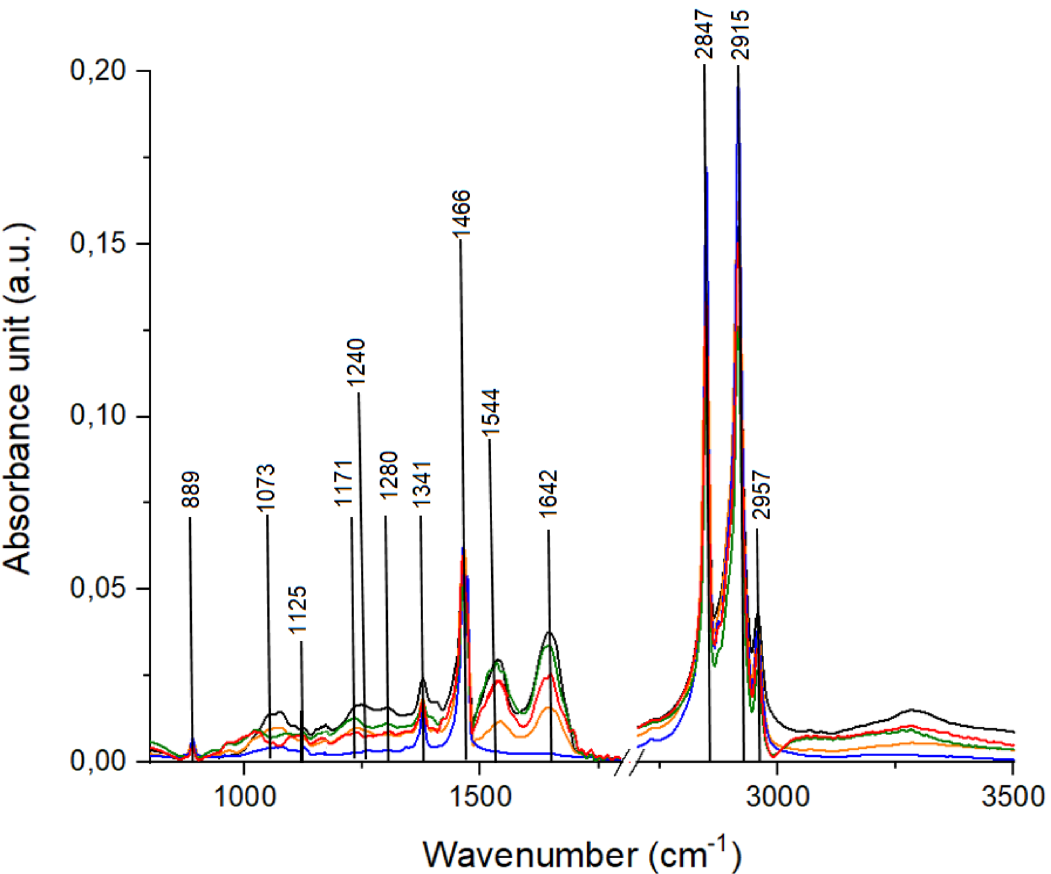
Figure 2. FTIR spectra of samples: control (black spectrum); atrophic endometrium (orange spectrum); complex atypical hyperplasia (red spectrum); endometrial polyp (green spectrum); endometrioid adenocarcinoma (blue